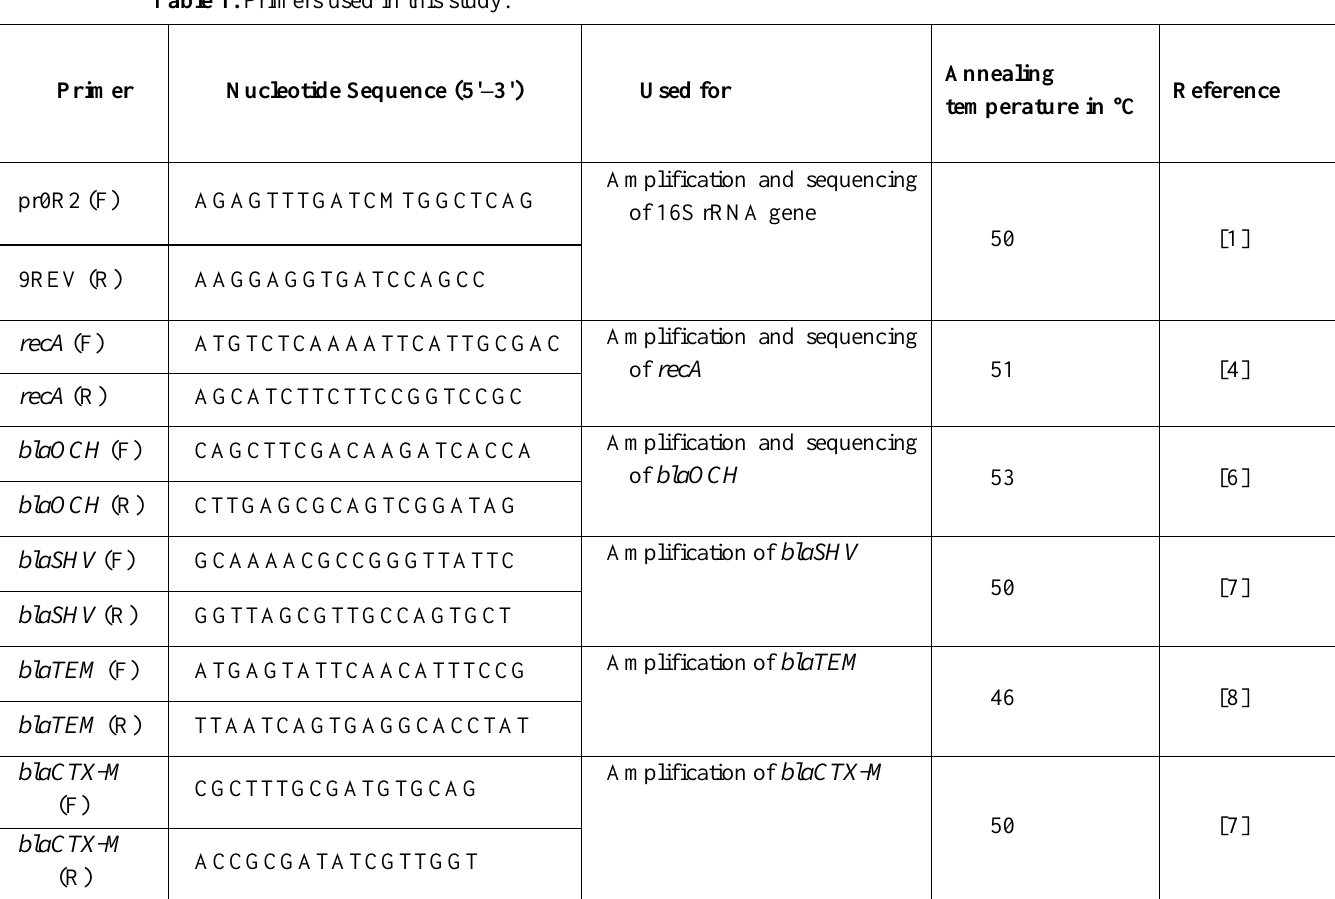
Table 1. Primers used in this study.